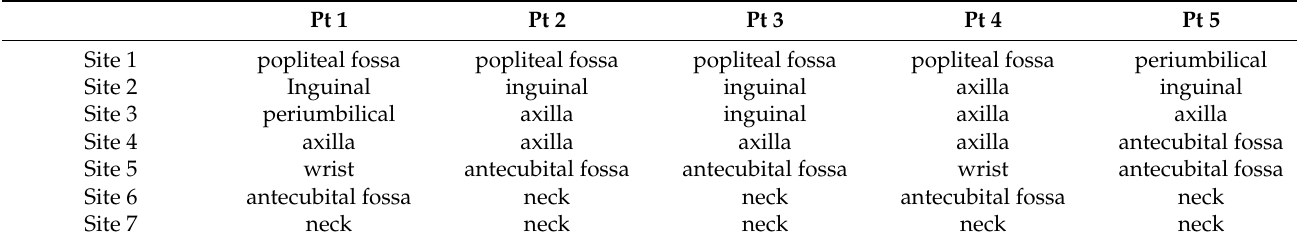
Table 4. The investigated skin sites of the pseudoxanthoma elasticum